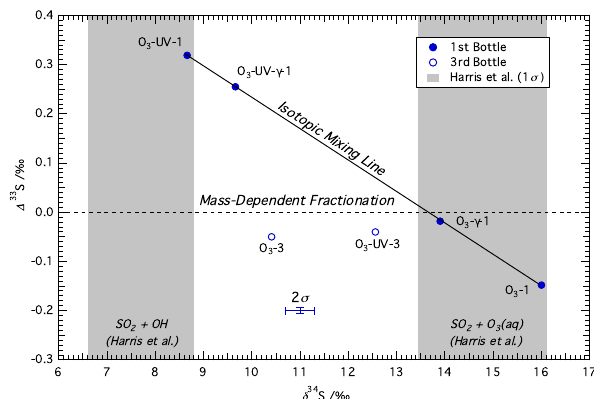
Fig. 2. δ 34 S and 1 33 S for the analyzed samples, taken from Table 1. Fig. 2. δ 34 S and ∆ 33 S for the analyzed samples, taken from Table 1. Labels show the sample ID. Also shown Labels show the sample ID. Also shown are the 2 σ error bars in the are the 2 σ error bars in the δ 34 S and ∆ 33 S axes. The value for the OH and O 3 (aq) reactions from Harris et al. δ 34 S and 1 33 S axes. The value for the OH and O 3 (aq) reactions (2012) are also shown in grey (width: 1 σ ). The line indicates the mixing of different production processes and from Harris et al. (2012) are also shown in grey (width: 1 σ ). The their resulting isotopic composition. line indicates the mixing of different production processes and their resulting isotopic